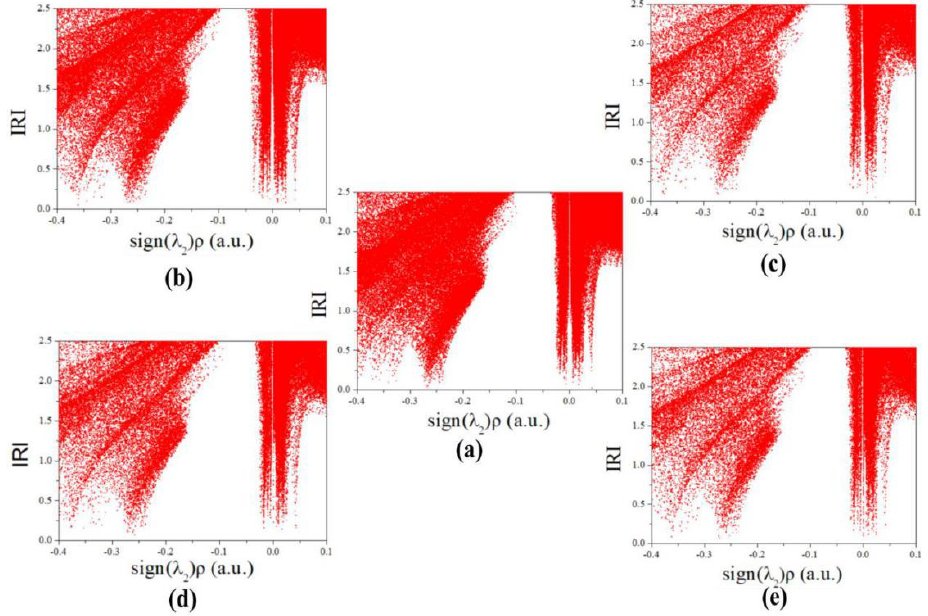
Figure 11. Plots of IRI for CL-20 and its host － guest complex: ( a ) CL － 20, ( b ) CL － 20/H 2 O 2 , ( c ) CL － 20/CO 2 , ( d ) CL － 20/N 2 O, and ( e ) CL － 20/H 2 O. ( c ) CL-20/CO 2 , ( d ) CL-20/N 2 O, and ( e ) CL-20/H 2 A comparison of molecular polarity index values reveals that the guest molecules and CL-20/H 2 O 2 (19.5 kcal·mol − 1 ) correspond to the macropolar host–guest complex more than CL-20 (18.61 kcal·mol − 1 ). CL-20/CO 2 (14.95 kcal·mol − 1 ) has the smallest polarity. The